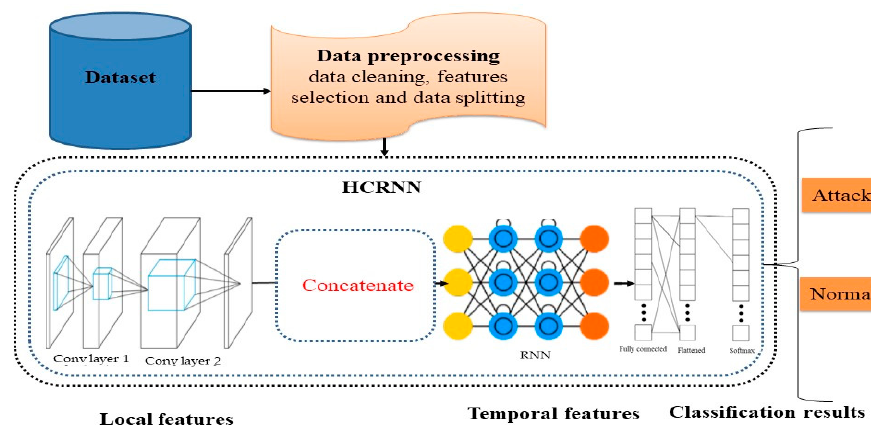
Figure 1. Overview of the HCRNNIDS.